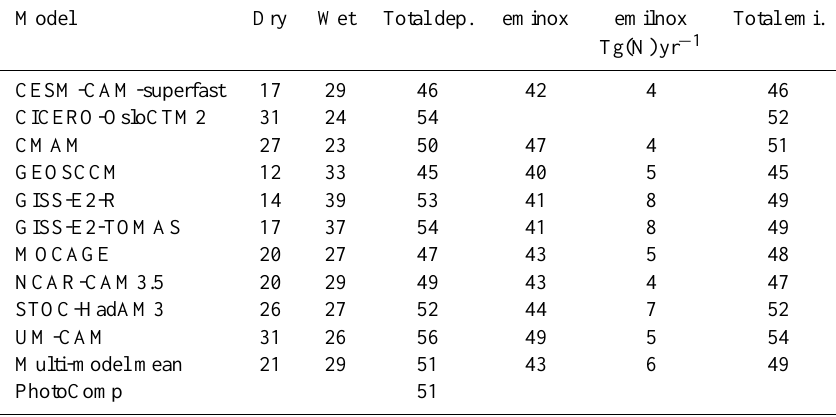
Table 2. Summary of global totals (Tg(N)yr − 1 ) for deposition and emissions in 2000 related to the nitrogen oxide emissions. “Total dep.” (4th column) is the sum of wet and dry deposition, while “Total emi.” (7th column) is the sum of NO x surface and aircraft emissions (eminox) and lightning emissions (emilnox). Note that deposition is equal or slightly larger than emissions due to the net input of nitrogen (usually in the form of nitric acid) from the stratosphere (approximately 1Tg(N)yr − 1 , except for the GISS models which have a 5Tg(N)yr − 1 input from the stratosphere). All numbers are rounded to the nearest integer.